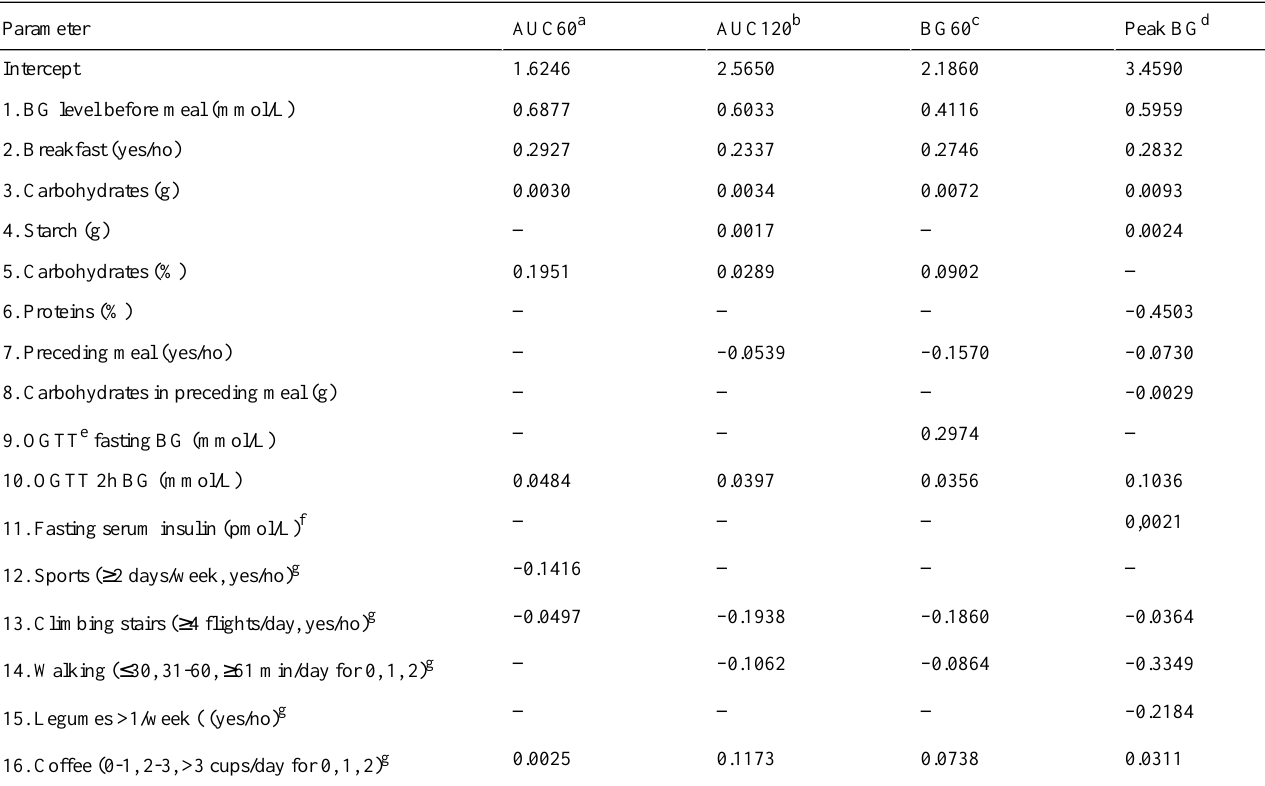
Table 3. Coefficients of the linear regression models predicting different features of postprandial glucose (PPG)